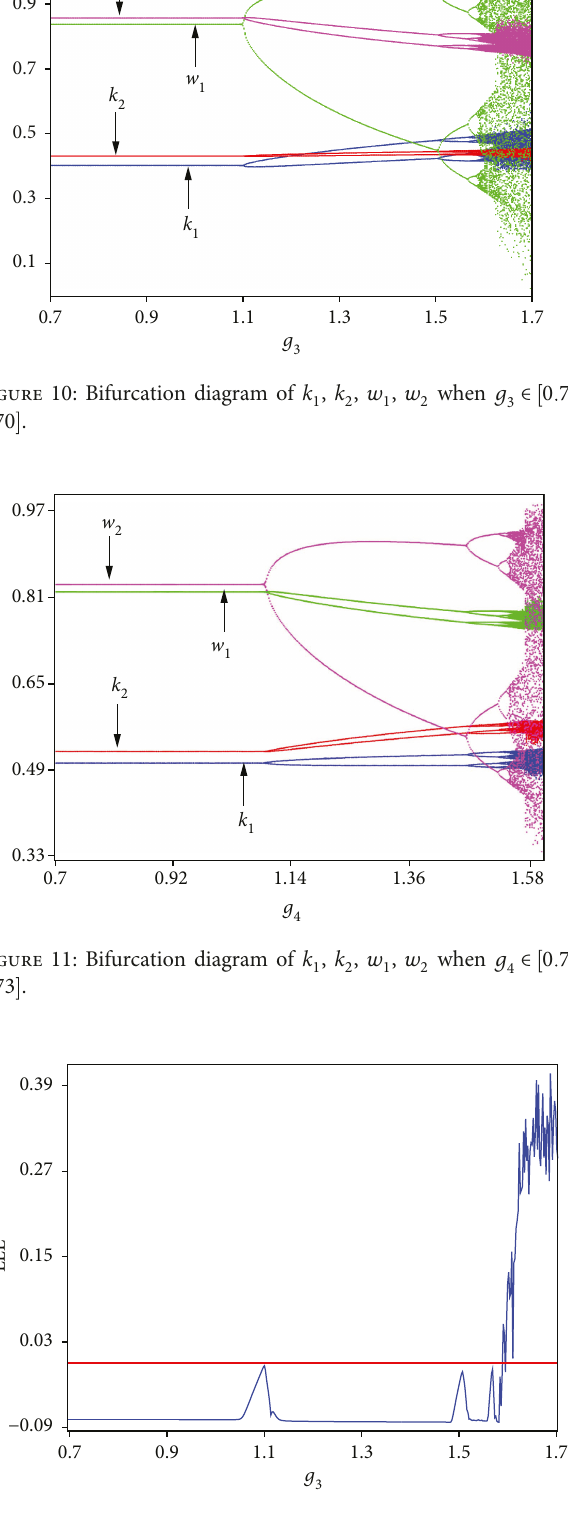
Figure 12: The largest Lyapunov exponent of the system with respect to g 3 ∈ 0 7, 1 70 .